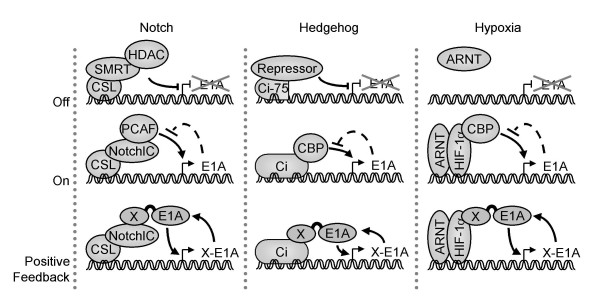
Three possible examples of tumor-specific targeting using E1A fusion proteins. In each case E1A is fused to a protein domain (X) that binds to a protein normally found at the promoter in increased amounts in tumor cells. Notch Pathway: in the absence of a signal, CSL recruits co-repressors; upon signaling, NotchIC is released, binds to CSL and activates transcription. Hedgehog pathway: in the absence of a signal, Cubitus Interruptus is cleaved to its repressor form; upon signaling, full-length Ci is produced and activates transcription. Hypoxia pathway: in normoxia, HIF1α is degraded; in hypoxia, HIF1α is stabilized, dimerizes with ARNT, binds to DNA and activates transcription.